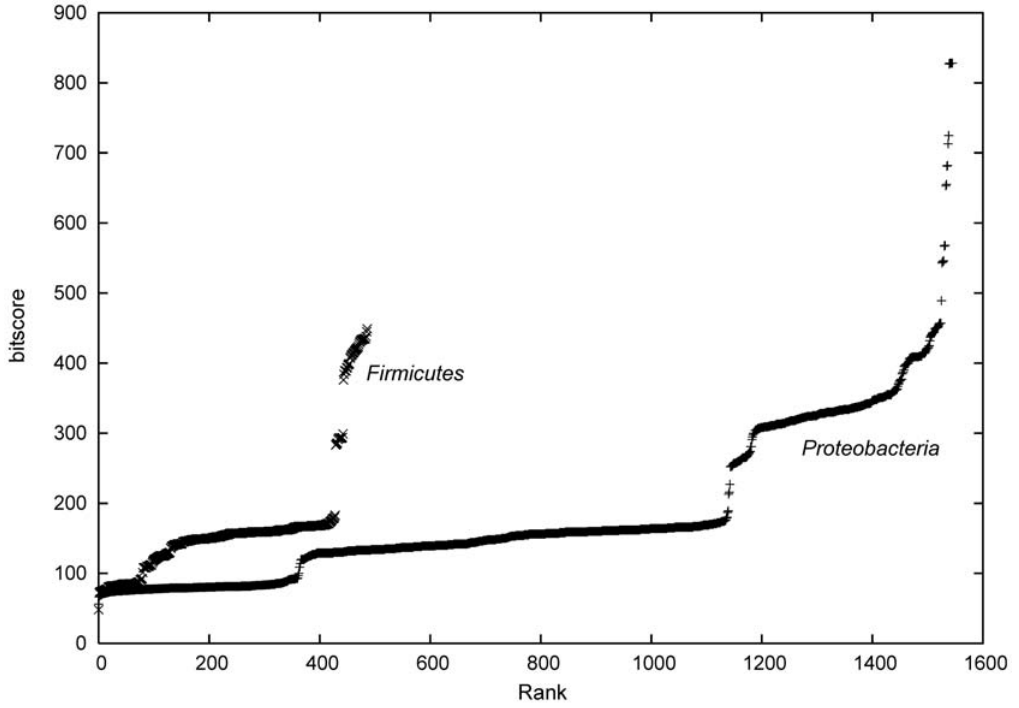
Figure 5. Ranking of the most significant protein alignments from all genomes was done according to their BLAST bitscore (BLOSUM62 substitution matrix, e -value , 10 2 5 ). The query protein was of the YscN gene from Yersinia pseudotuberculosis (UniProt ID